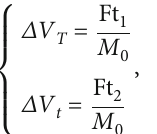
Table 3: Initial parameters of the